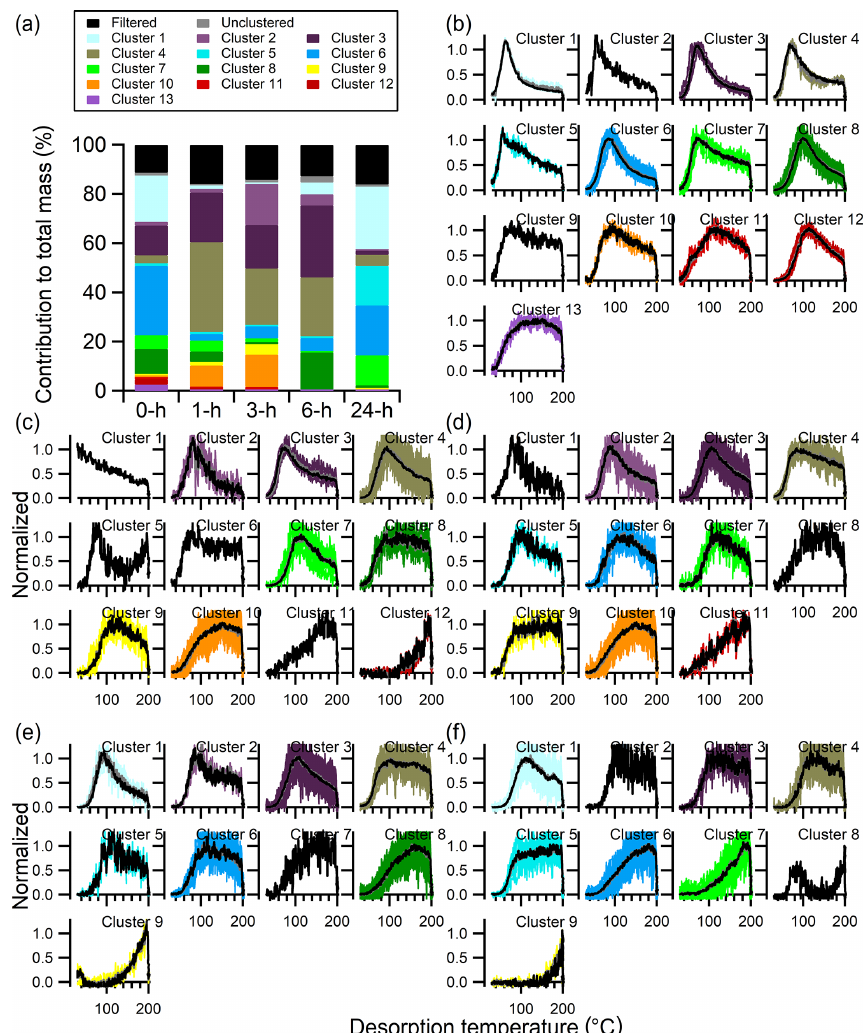
Figure 13. Multiple-clustering results for α -pinene + O 3 SOA as a function of isothermal evaporation time. (a) The contribution of each cluster to the total mass for each experiment, along with the contributions of filtered-out ions (black bar) and unclustered ions (gray bar). The number of clusters obtained generally decreases with isothermal evaporation time. (b–f) The unweighted average (gray) and mass-weighted average (black) thermograms, along with the thermograms of individual members of clusters for the (b) 0h, (c) 1h, (d) 3h, (e) 6h, and (f) 24h wait experiments. The cluster colors are consistent between